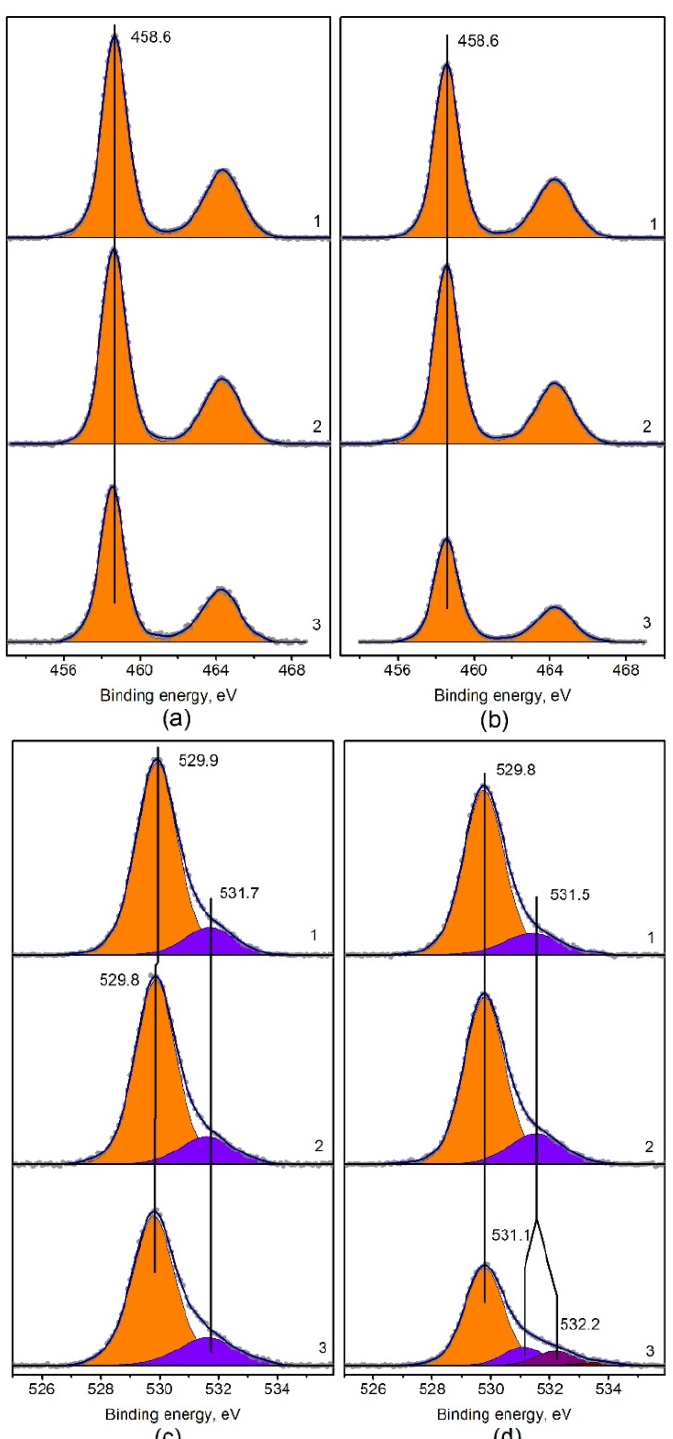
Figure A3. Ti2p fitted XPS spectra of ( a ) Pt/Ti-PLA-400 and ( b ) Pt/Ti-P25-400 catalysts; O1s fitted XPS spectra of ( c ) Pt/Ti-PLA-400 and (d) Pt/Ti-P25-400 catalysts, calcined at 400 ° С (1), 600 ° С (2) and 800 ° С (3). O1s spectra are normalized to the Ti2p area of Pt/Ti-PLA-400 sample.